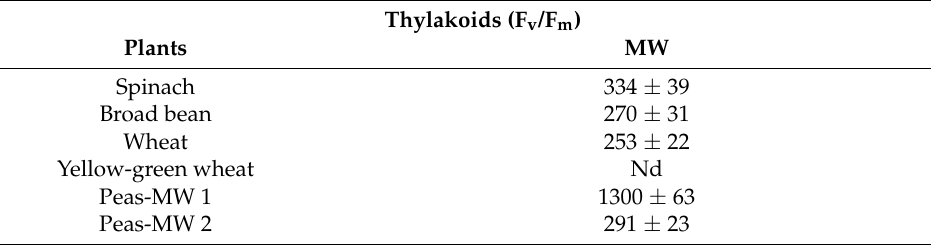
Table 3. Radiation target analyses of thylakoids, photosystem II (PSII) particles and PSII cores. The fluorescence and electron transfer from H 2 O or diphenylcarbazide (DPC) to 2,6- dichlorophenolindophenol (DCPIP) were measured as reported in the Materials and Methods. Before irradiation, the initial PSII activity of the controls averaged 0.856 ± 0.005 for fluorescence F v /F m , and 300 ± 28 µ mol DCPIP reduced per mg of Chl h − 1 for electron transfer activities. The molecular sizes (MW) in kDa were calculated according to Beauregard and Potier [32]. The experiments were repeated at least five times in independent preparations for each